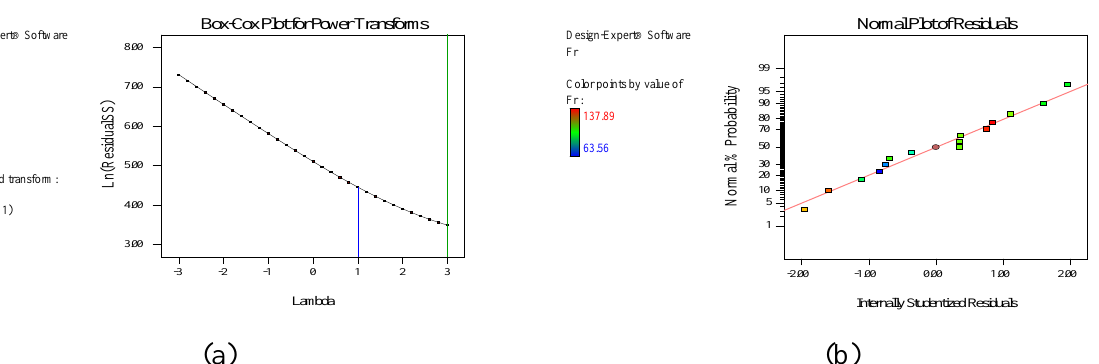
Fig. 5. Box-Cox plot (a)and normal plot of residuals (b) for Fa